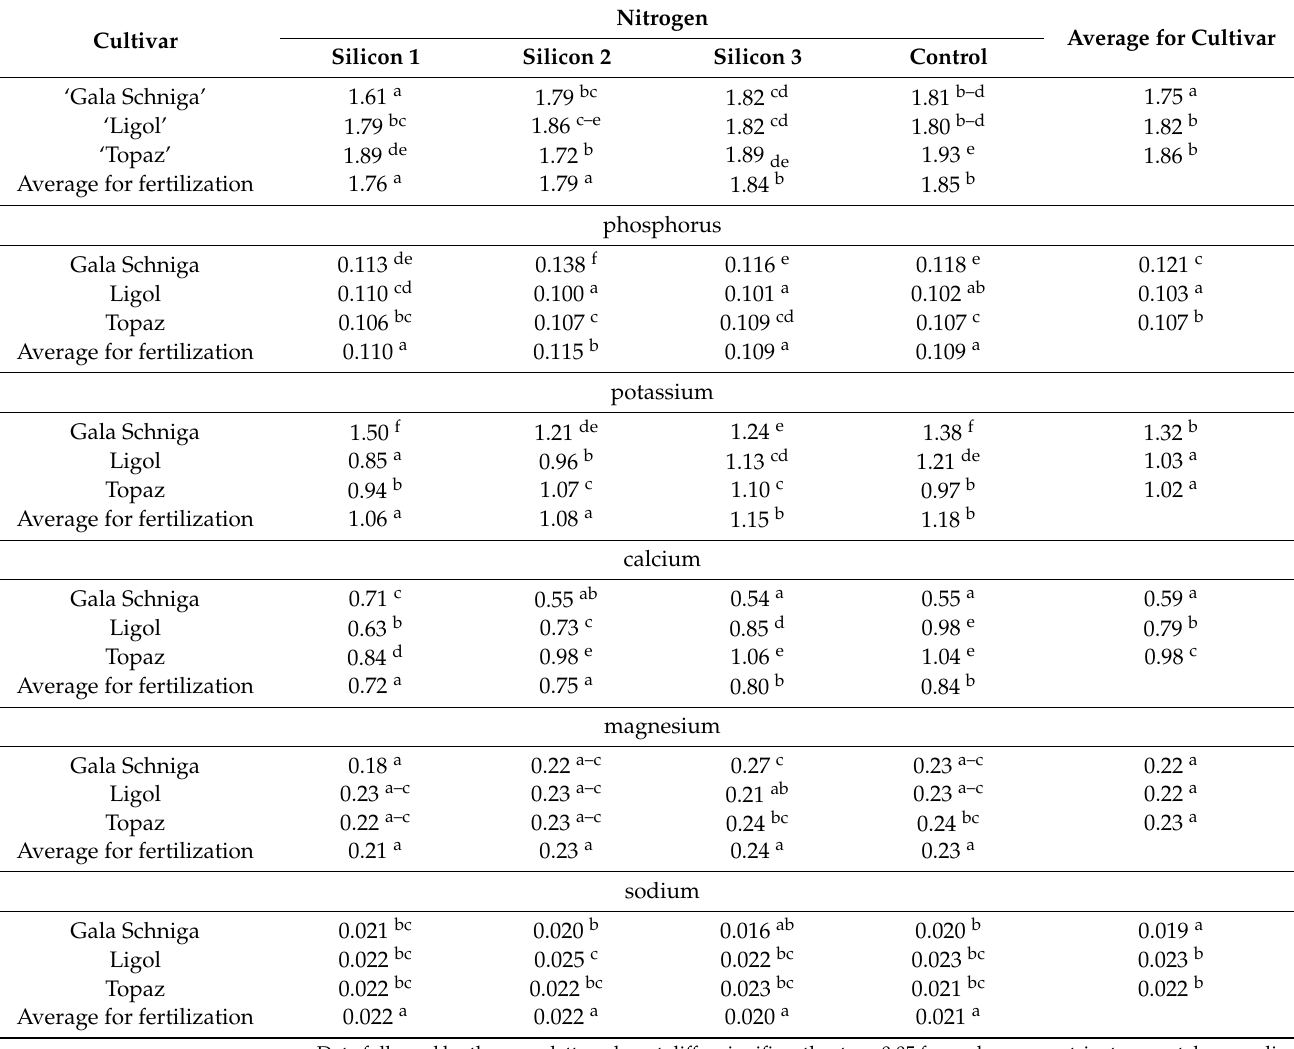
Table 13. The content of macronutrients in leaves of apple trees depending on cultivar and foliar silicon treatment (%).